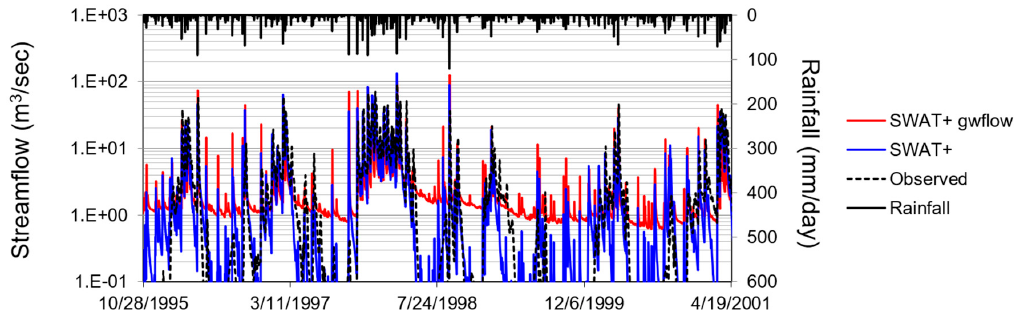
Figure 11. Comparison of daily streamflow at the outlet of the watershed (site B in Figure 6) simulated for the original SWAT+ model and the SWAT+ model with the new gwflow module. A semi-log plot is used to show the differences between the model results for low flows. The measured streamflow is also shown.